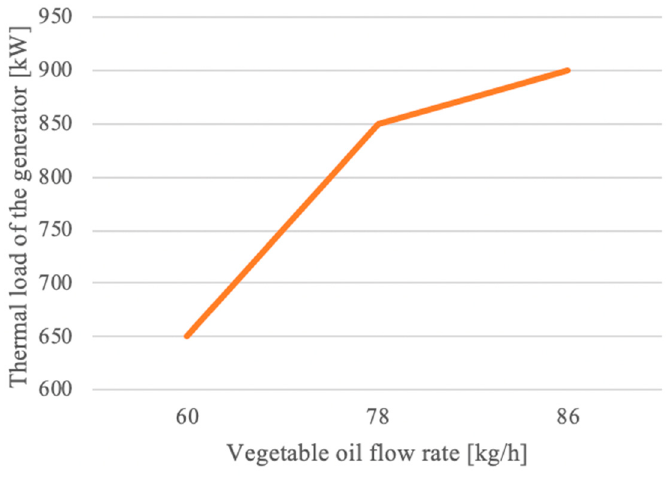
Figure 15. Thermal load variation with vegetable oil flow rate.